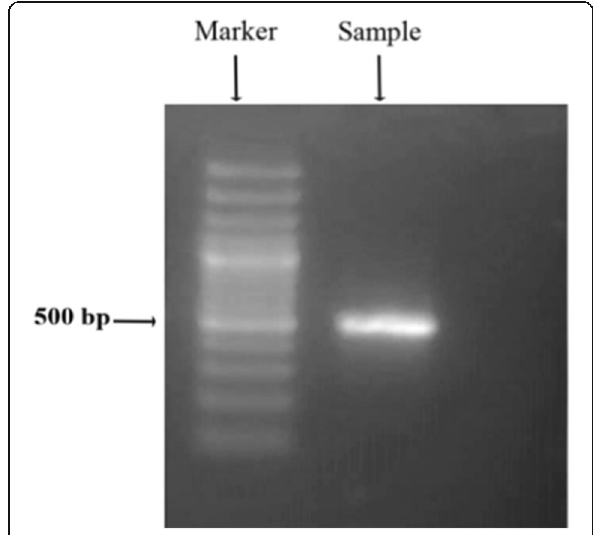
Fig. 2 Agarose gel electrophoreses of the amplified 18S rRNA gene of Chlorella sp. MF1